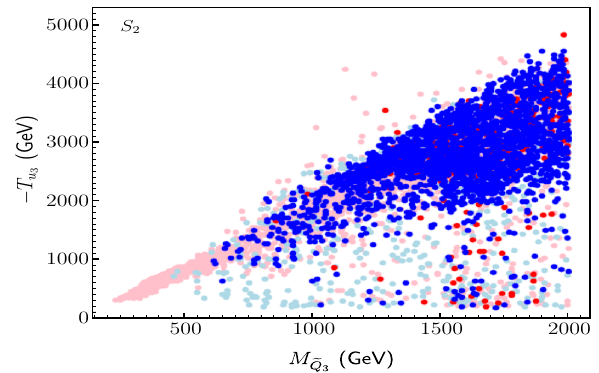
Fig. 9 Viable points of the parameter space for S 2 in the − T u m (cid:6) Q 3 L plane. The color code is the same as in Fig. 8